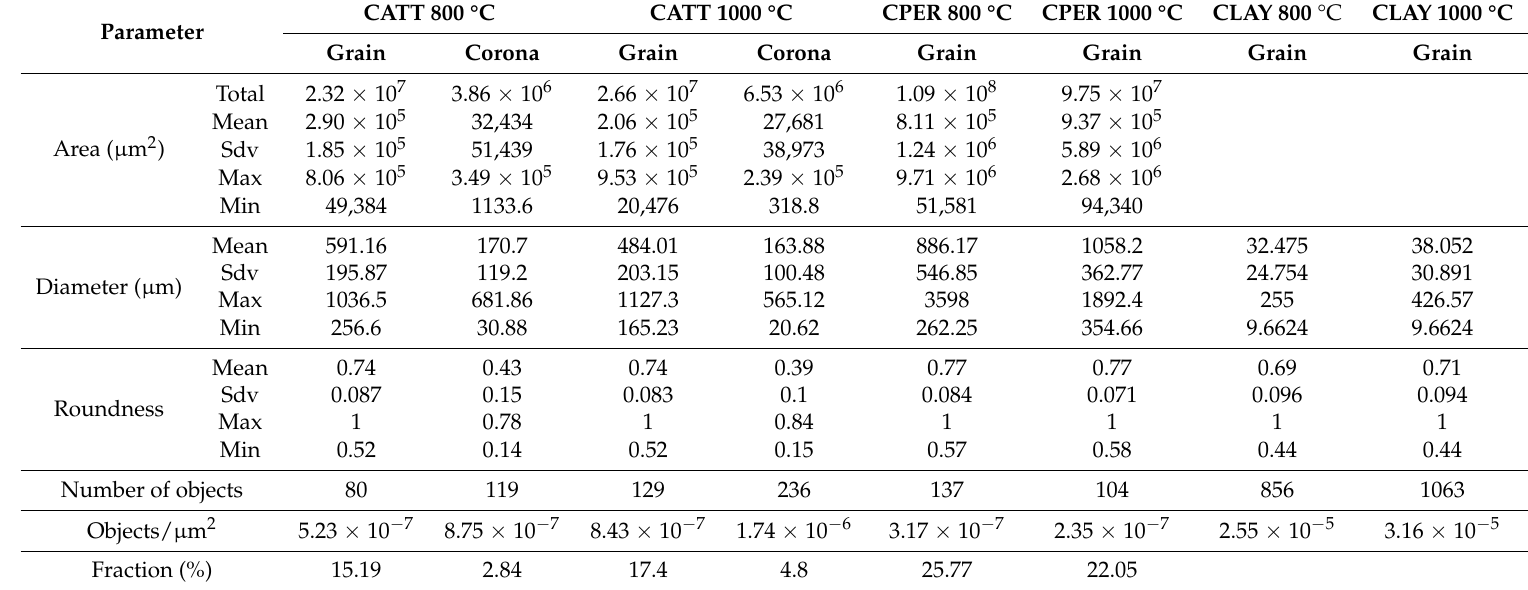
Table 1. Quantification of the CATT, CPER and CLAY microstructural parameters